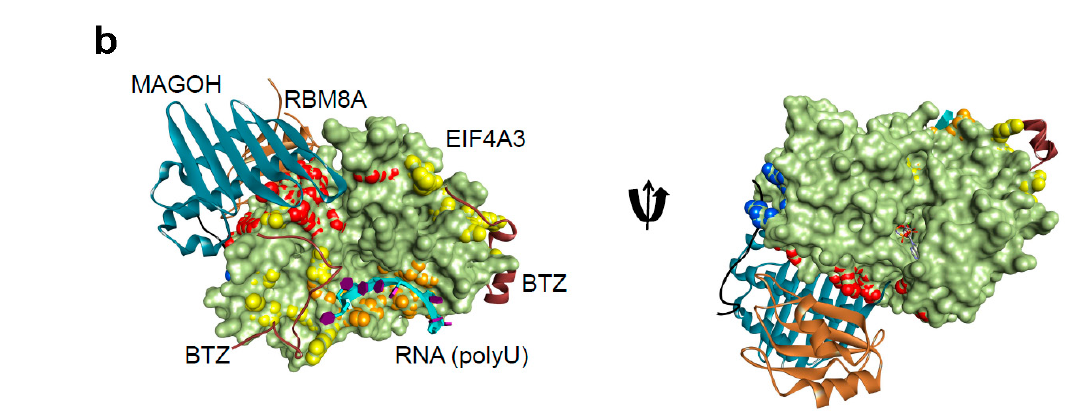
Figure 2. The protein-protein and protein-RNA binding interface for the NMD components, from the Protein Data Bank database (http: // www.rcsb.org / pdb) [31–34,36,103–112]. ( a ) NMD pathway schematic representations, and protein-protein interactions form the complex: UPF1-UPF2 (PDB: 2wjv) [34], UPF2-UPF3b (PDB: 1uw4) [36], SMG5-SMG7 (PDB: 3zhe) [105,112], SMG8-SMG9 (PDB: 5nkk) [106], SMG1– SMG8–SMG9 (PDB: 6syt ) [107]. (b) The exon junction complex; Mago-Y14-eIF4AIII-Barentsz-UPF3b (PDB: 2xb2) [108] (Table 1). The H-bond analysis was performed using BIOVIA Discovery Studio Visualizer program [Dassault Systemes, BIOVIA Corp., San Diego, CA, USA]. Table 1. The crystal structures available for the protein-protein binding interface available for di ff erent NMD components, from the Protein Data Bank database (http: // www.rcsb.org / pdb) [111]. UPF: up-frameshift; SMG: suppressor of morphogenetic e ff ect on genitalia. Protein Interacting Partners PDB